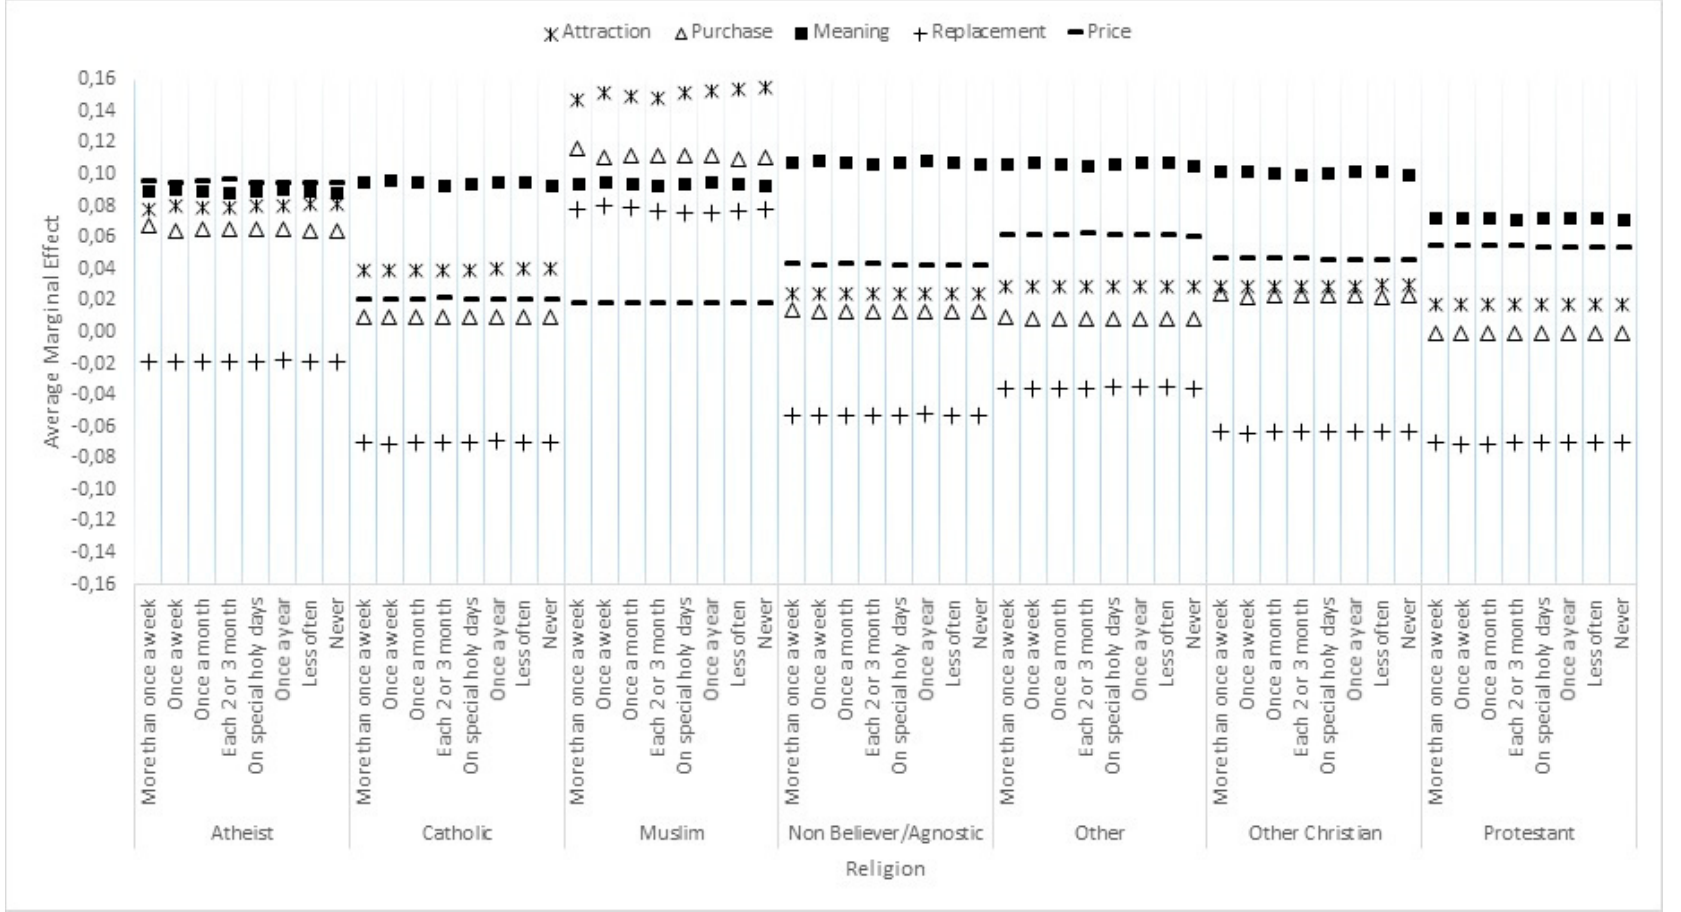
Figure 3. Logit marginal effects. Attitudes and purchasing intentions for innovative products vs. religion/religiosity.